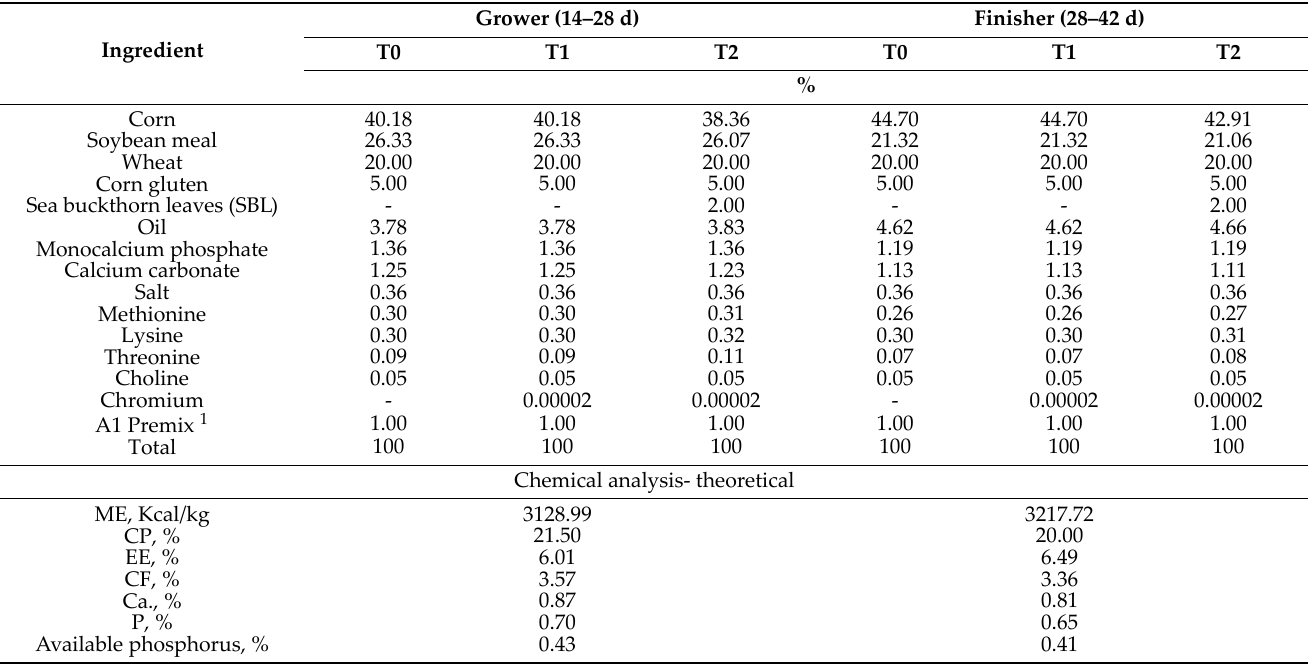
Table 1. Main ingredients and nutrient analysis of the diets